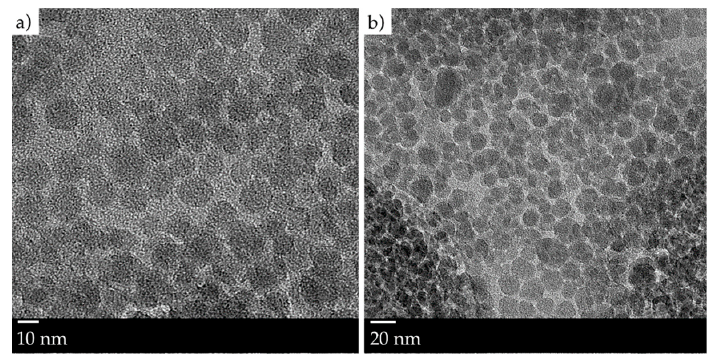
Figure 1. Chemical structures of dithiol ( a ) and triallyl ( b ) monomers.